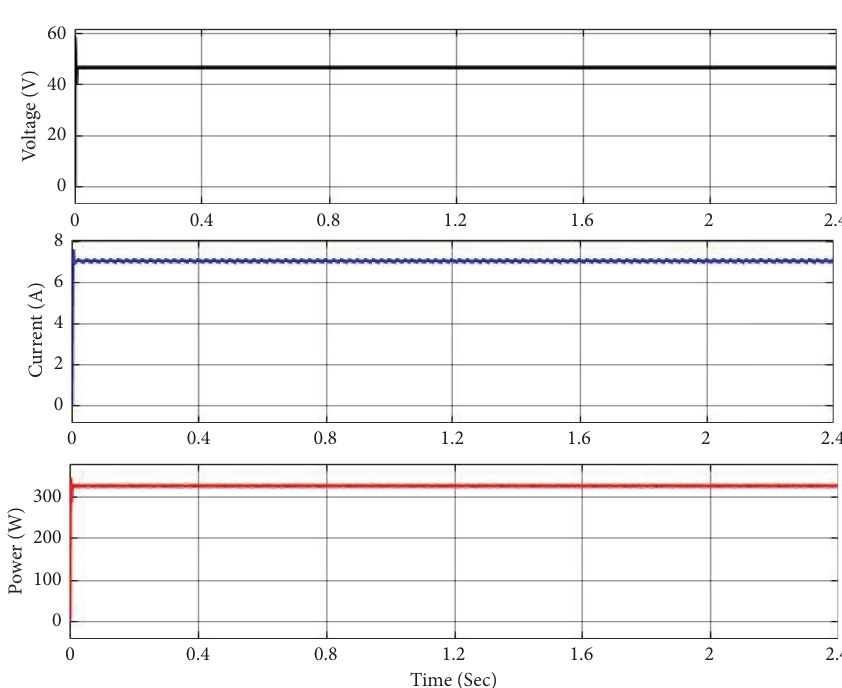
Figure 14: Input voltage, current, and power at